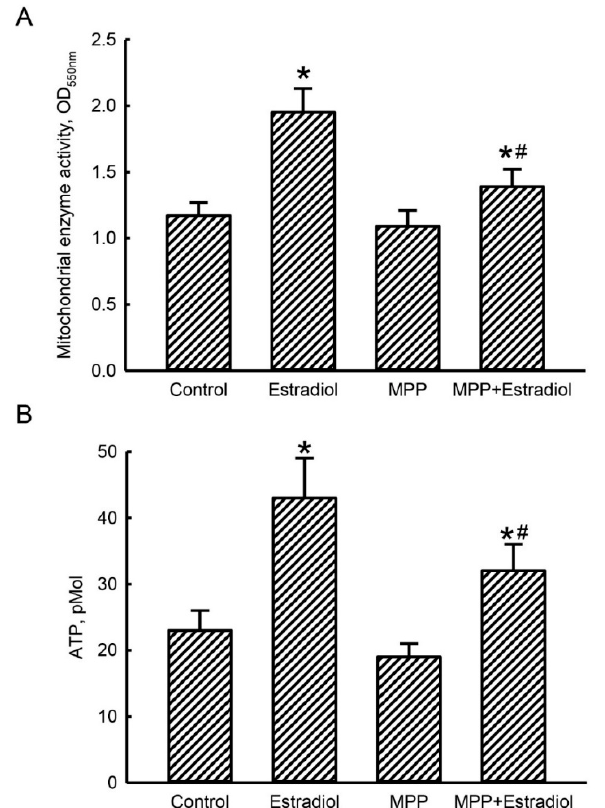
Figure 4. Methylpiperidinopyrazole (MPP) reduced estradiol-triggered enhancements in activities of mitochondrial respiratory complex enzymes and levels of cellular ATP in rat calvarial osteoblasts. Primary osteoblasts isolated from neonatal rat calvarias were exposed to 10 nM estradiol, 100 µ M MPP, and a combination of MPP and estradiol for 24 h. After drug treatment, mitochondrial complex enzyme activities were assayed with a colorimetric method ( A ). Levels of cellular ATP were measured with a bioluminescence assay ( B ). Each value represents the mean ± standard deviation of at least three independent determinations. The symbols * and # indicate that values significantly ( p < 0.05) differed from the control and estradiol-treated groups, respectively.